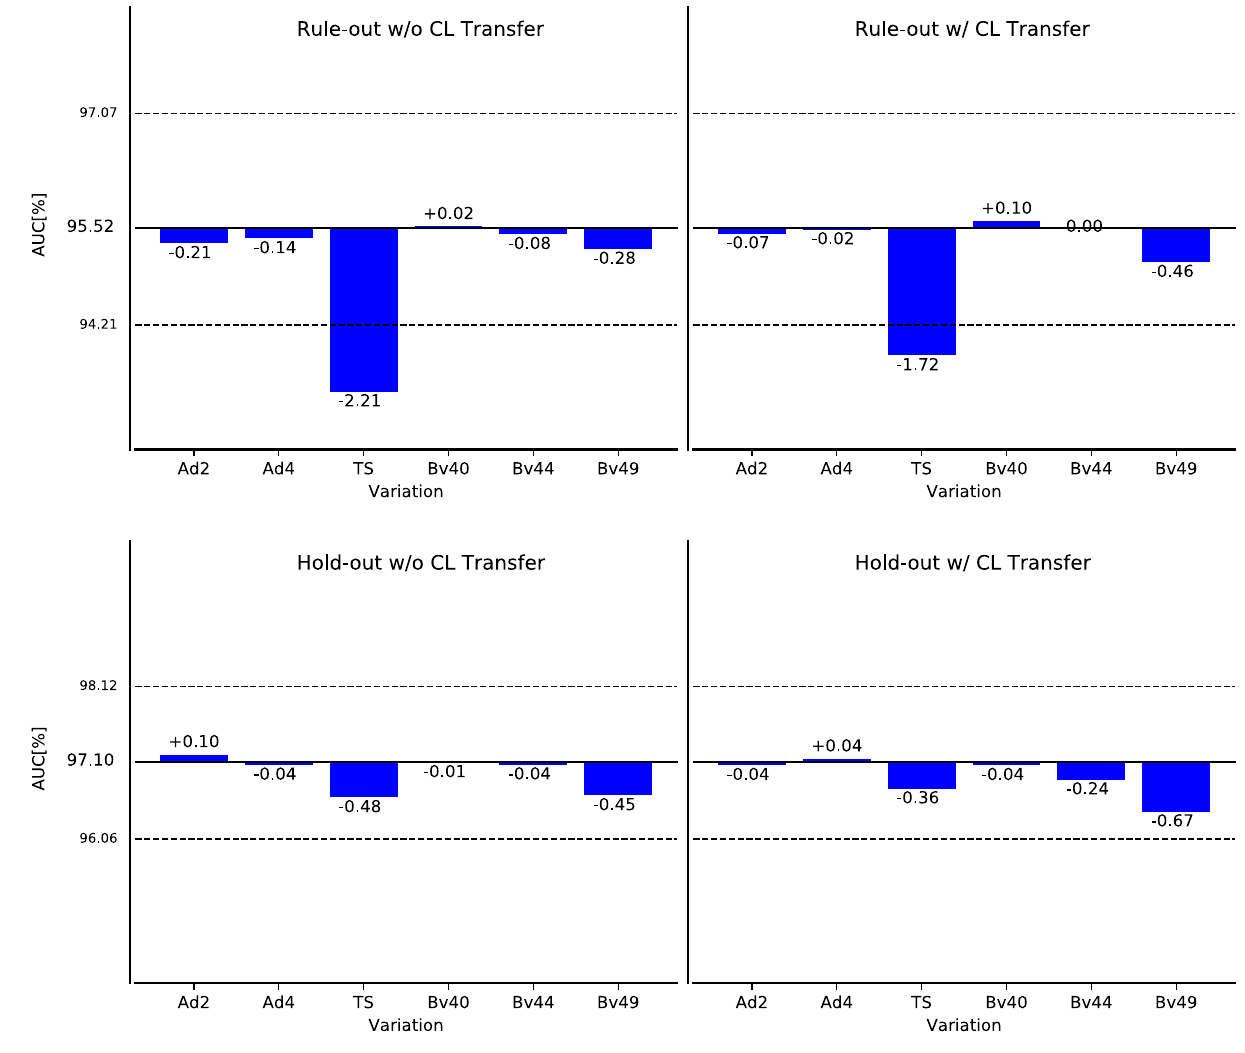
Figure 7. Performance on the data set A with all configurations (abbreviations as in Table 1) compared to the default for the rule-out and hold-out task, with and without centerline propagation. The dashed lines correspond to the 95% Confidence Interval (CI) for the default configuration. Note that the performance of the default configuration does not depend on the preprocessing as the centerlines of the default configuration are